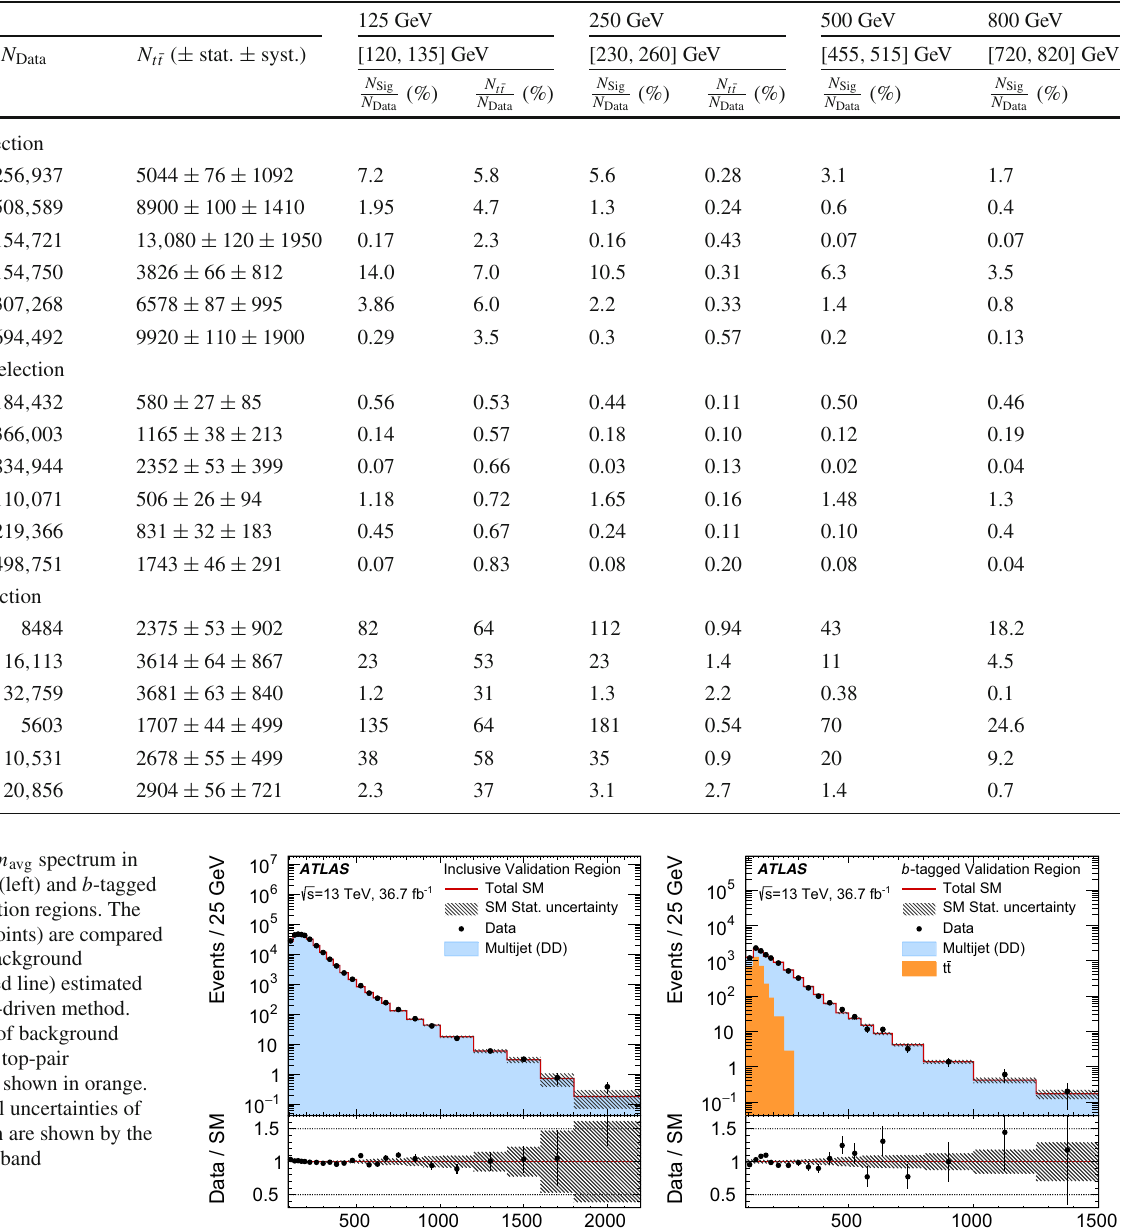
Table 2 Observed numbers of events and the predicted t ¯ t contributions in each of the regions used in the background estimate, for each b -tag multiplicity. The expected fractional signal contributions are shown for the mass windows corresponding to m ˜ t = 125, 250, 500, and 800 GeV.